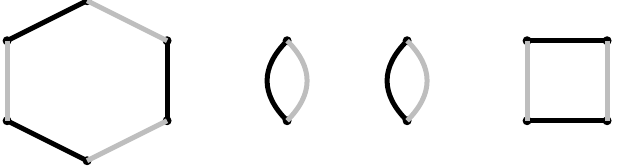
Figure 2 . An example graph G with all even cycles decomposed as A [ B where thick black edges are A and thick grey edges are B